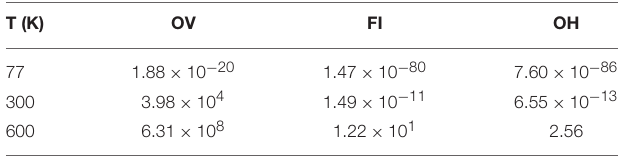
prefactor of 1 × 10 13 s − 1 . These values, are collected in Table 2